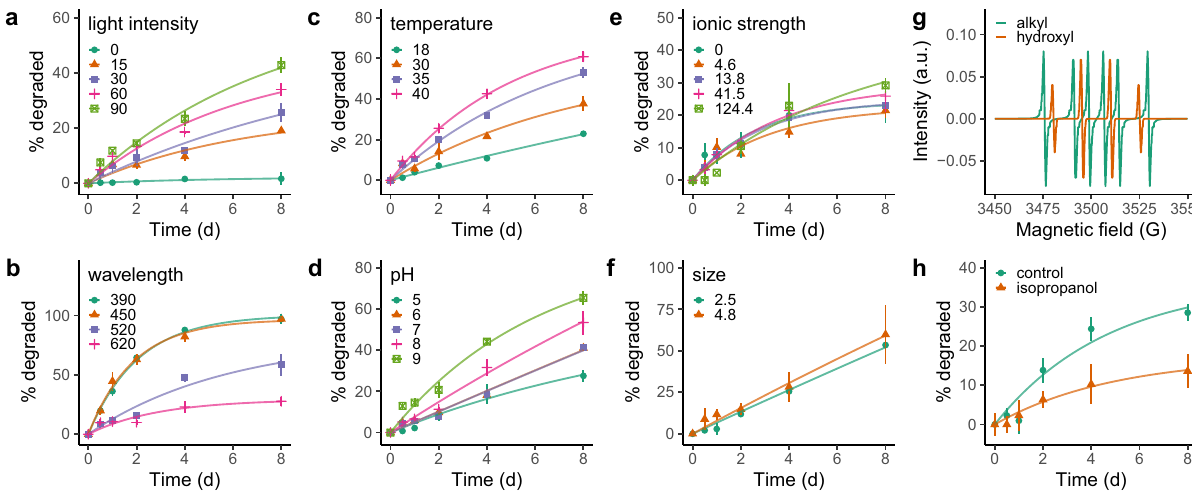
Fig. 1 Photodegradation of laboratory-synthesized carbon dots (CDs). a – d More CDs degraded at higher light intensity (0, 15, 30, 60, and 90 μ mol photons/m 2 /s) ( a ), shorter light wavelength (390, 450, 520, and 620 nm) ( b ), higher temperature (18, 30, 35, and 40 °C) ( c ), and pH (5, 6, 7, 8, and 9) ( d ). e Ionic strength (0, 4.6, 13.8, 41.5, and 124.4 mM) had no effects on CD degradation. f CDs with different sizes (2.5 and 4.8 nm) show similar degradation kinetics. g Free hydroxyl and alkyl radicals were produced when CDs were irradiated by white fl uorescent light (60 μ mol photons/m 2 /s). h When the hydroxyl radicals were scavenged by 10 mM isopropanol, less CDs degraded as compared to the control treatment without any addition of isopropanol. Data are presented as the mean ± s.d. ( n = 3 independent experiments). Source data are provided as a Source Data fi